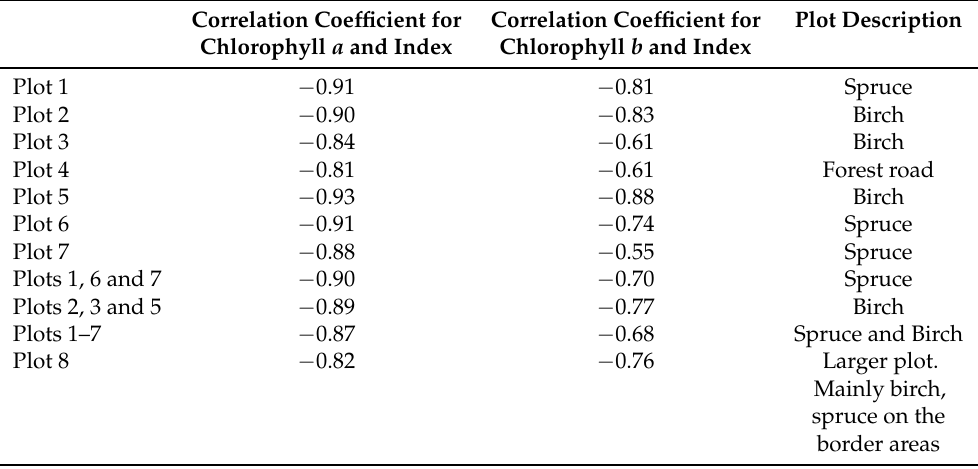
index in the eight OSAVI